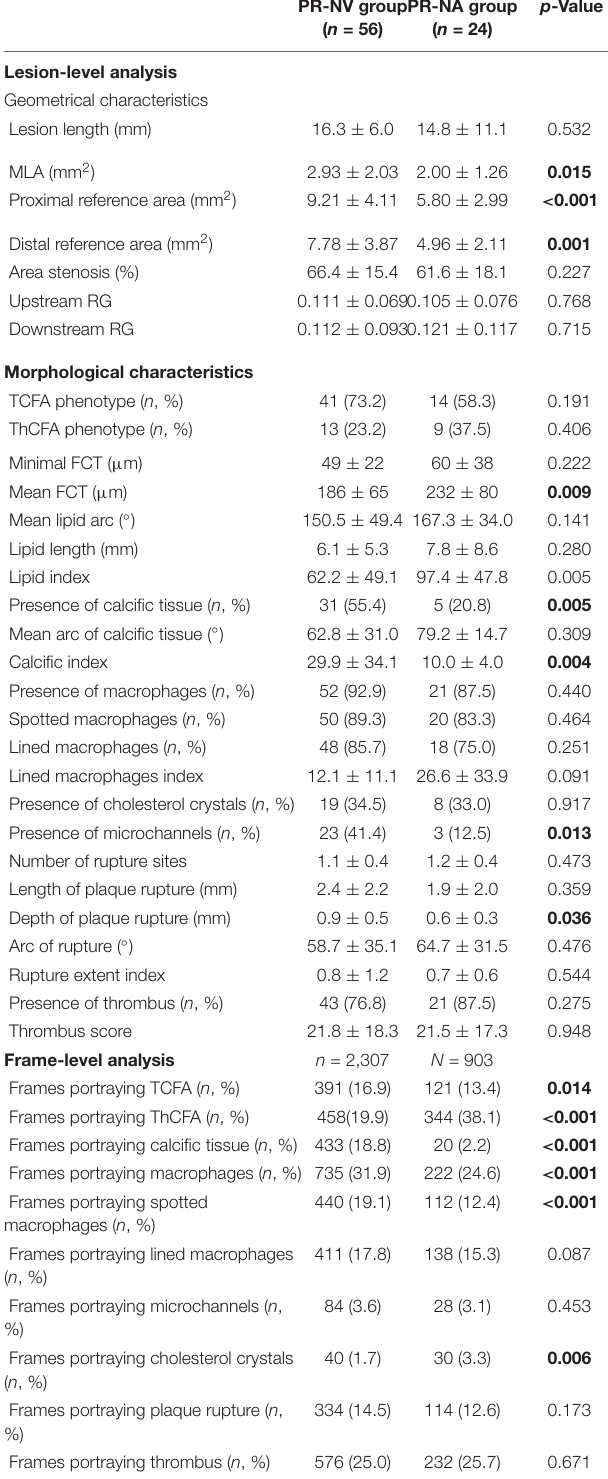
TABLE 2 | Geometrical and morphological characteristics of the ruptured plaques in the native and stented